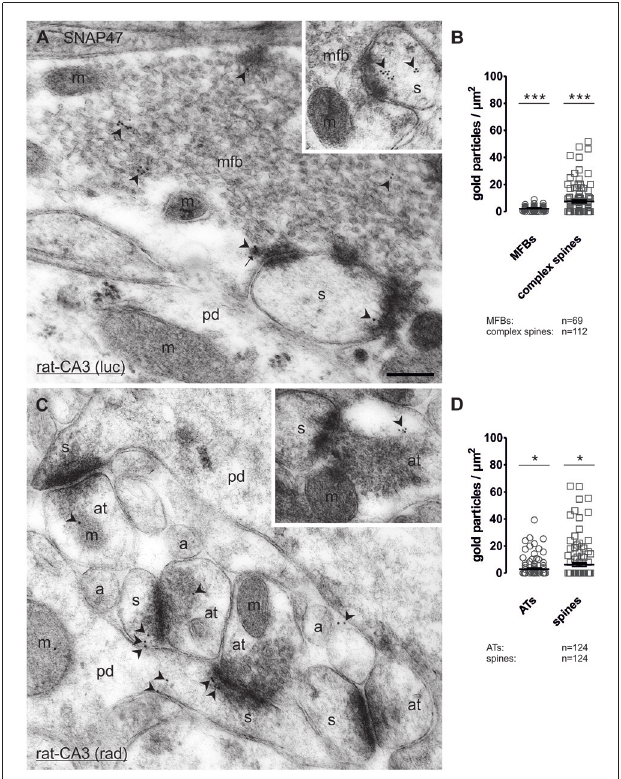
FIGURE 10 | Quantitative immunoelectron microscopy of SNAP47 immunolabeling in glutamatergic neurons of the rat hippocampus. (A) Electron micrograph of a MF bouton (mfb) in the CA3 stratum lucidum labeled for SNAP47 (10 nm immunogold particles, arrowheads). The inset illustrates the high postsynaptic localization of SNAP47 in a spine head (s). Abbreviations: pd, pyramidal cell dendrite; m, mitochondrium; arrow, dense core vesicle. Scale bar: 500 nm. (B) Summary chart of the pre- and postsynaptic immunogold labeling density in the stratum lucidum of the CA3 area. Individual density values are superimposed for MFBs (open circles) and complex spines (open squares). (C) Postembedding immunogold labeling for SNAP47 in the CA3 stratum radiatum . Note that the immunogold labeling (arrowheads) is preferentially localized to spines (s) forming asymmetrical synapses with putative glutamatergic axon terminals (at), but was also observed in dendritic shafts of pyramidal cell dendrites (pd) and, at lower level, in axon terminal (inset). Abbreviations: a, axon. Scale bar: 500 nm. (D) Summary chart of pre- and postsynaptic immunogold labeling density in the stratum radiatum of the CA3 area. Individual density values are superimposed for axon terminals (AT, open circles) and spine heads (open squares). Asterisks indicate significant differences ( ∗∗∗ P < 0.0001 and ∗ P < 0.02) relative to background labeling measured over mitochondria in the stratum lucidum (B) and stratum radiatum (D) .